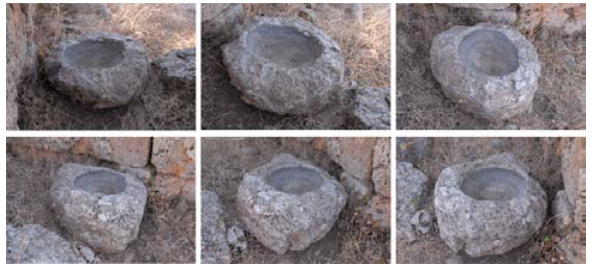
Figure 19. Collection of photos for the basin in court of the “Résidence”.